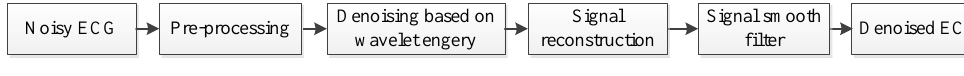
Figure 2. the framework of the proposed